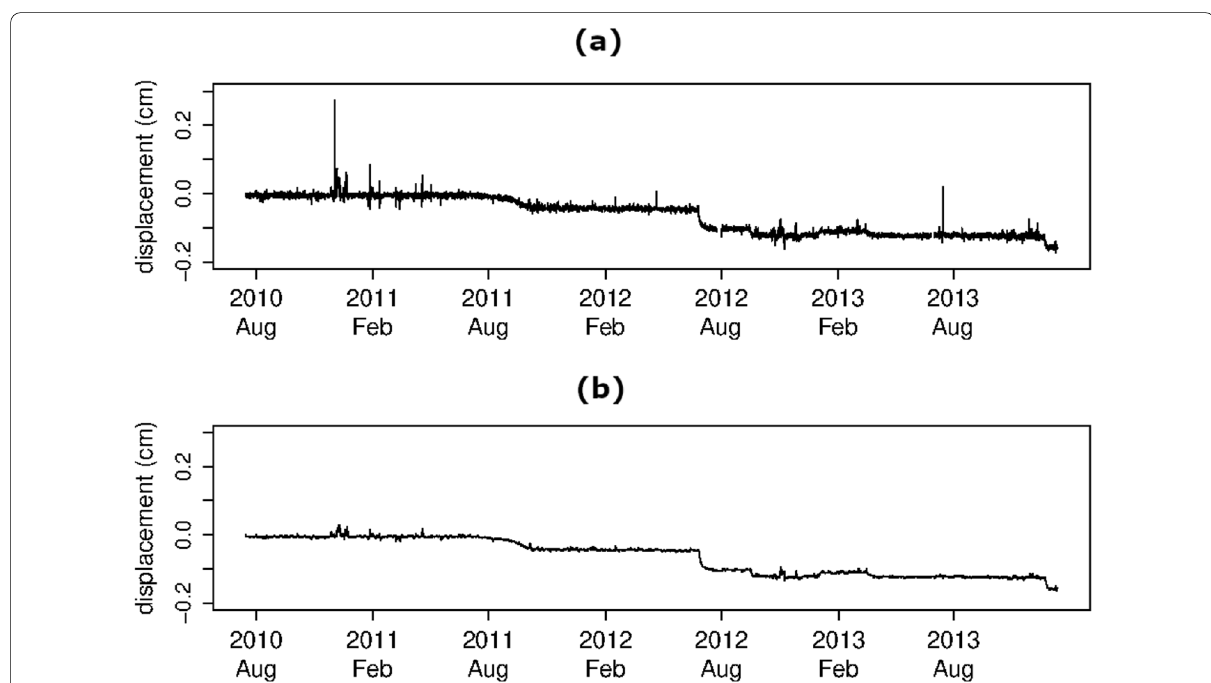
Fig. 3 a Data series about the displacement between FRON station and the GPS station of reference LPAL ( b ) these data series after removing outliers and applying a Kalman